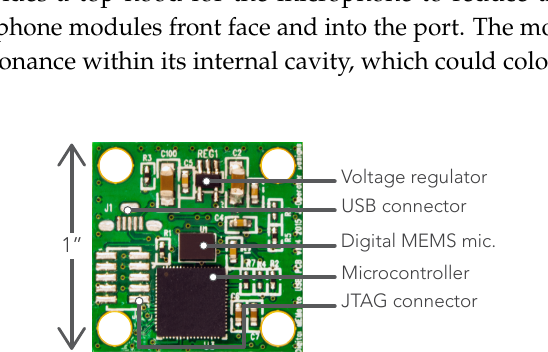
Figure 5. Digital acoustic sensing module detail with main component